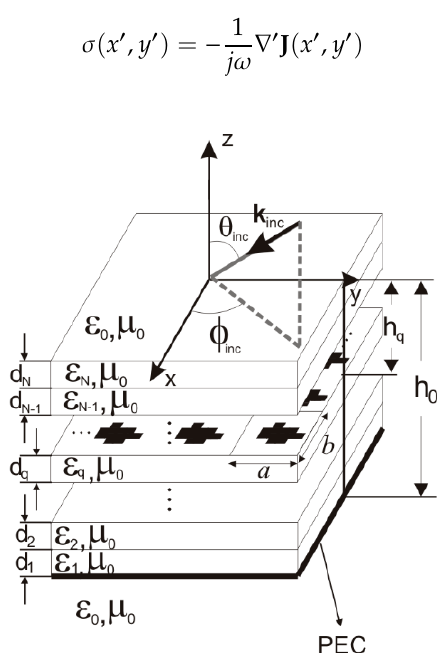
Figure 1. Periodic multilayer structure.